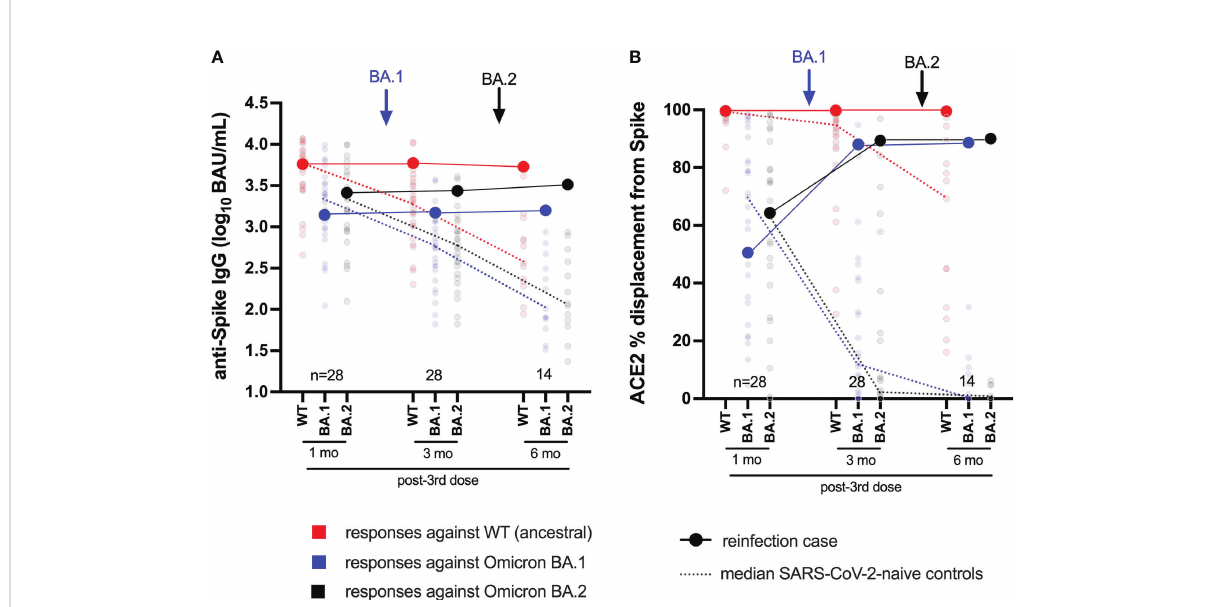
FIGURE 2 Longitudinal humoral responses against wild-type, BA.1 and BA.2 Spike antigens. Panel (A) Anti-Spike IgG concentrations, expressed in log 10 BAU/mL, in the case participant (large circles) versus a subset of the comparison group of SARS-CoV-2-naive individuals (small circles) at one, three and six months following three-dose COVID-19 vaccination. Wild-type-speci fi c (WT) anti-Spike responses are in red; BA.1-speci fi c ones are in blue; BA.2-speci fi c ones are in black. Matching solid lines connect the participant ’ s longitudinal values; dotted lines connect the median values for the comparison group. Approximate times of BA.1 and BA.2 infections are shown with arrows. Total Ns are shown at the bottom of the plot; the fi nal time point has a smaller N because some control participants were censored due to post-vaccination SARS-CoV-2 infection or had not yet completed the visit. Panel (B) same as (A) , but for longitudinal ACE2% displacement function from wild-type (red), BA.1 (blue) and BA.2 (black) Spike